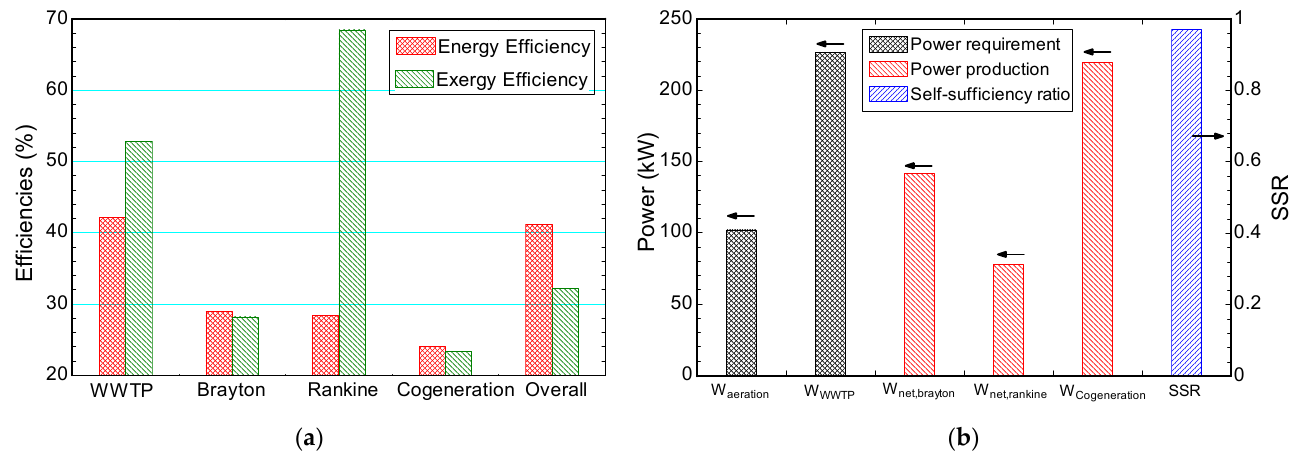
Figure 2. ( a ) Energy and exergy efficiencies for the case study, ( b ) Power requirement, power production and self-sufficiency ratio. Table 9 indicates the thermodynamic properties of each stream including mass flow rate, pressure, temperature, enthalpy, specific entropy and total specific exergy for the case study. Table 9. Thermodynamic properties of the base study.